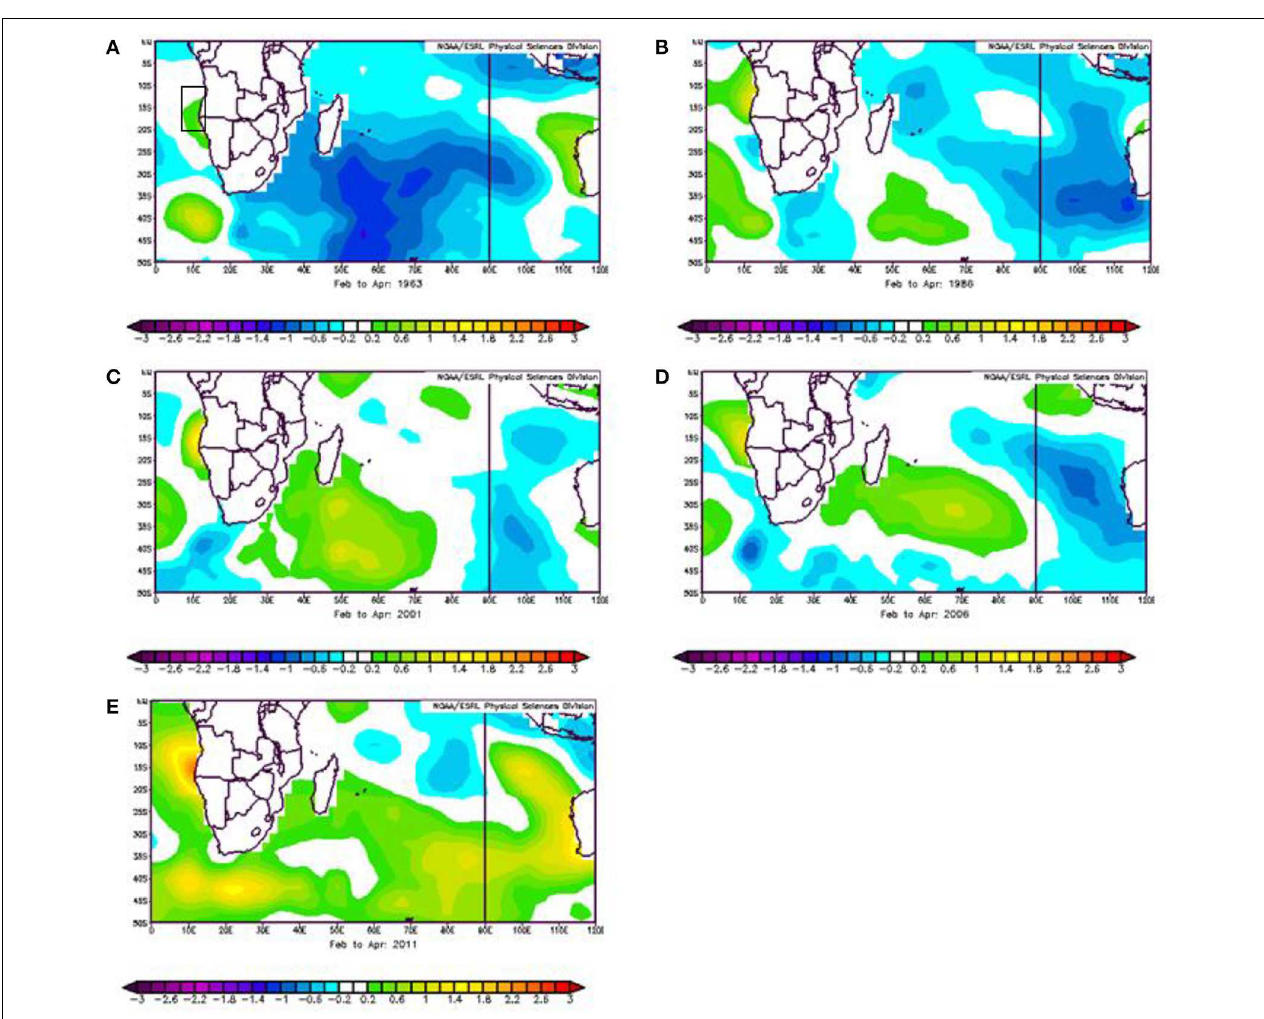
FIGURE 4 | Regional SST anomalies during the 5 strong events (A) 1963, (B) 1986, (C) 2001, (D) 2006, (E) 2011. Contour interval is 0.2 ◦ C. The ABA box used to define the Benguela Niño events is shown in A ).